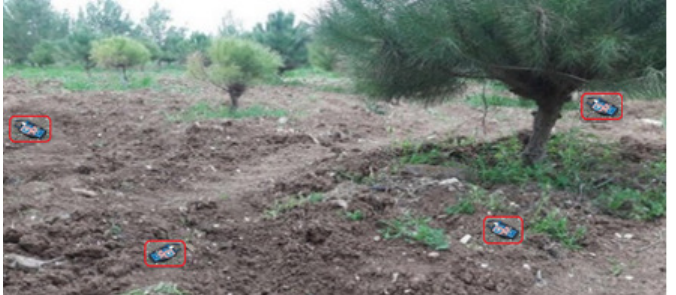
Figure 15. Wireless sensor nodes spread over non-line of sight area with observable obstacles at the German Jordanian University campus.